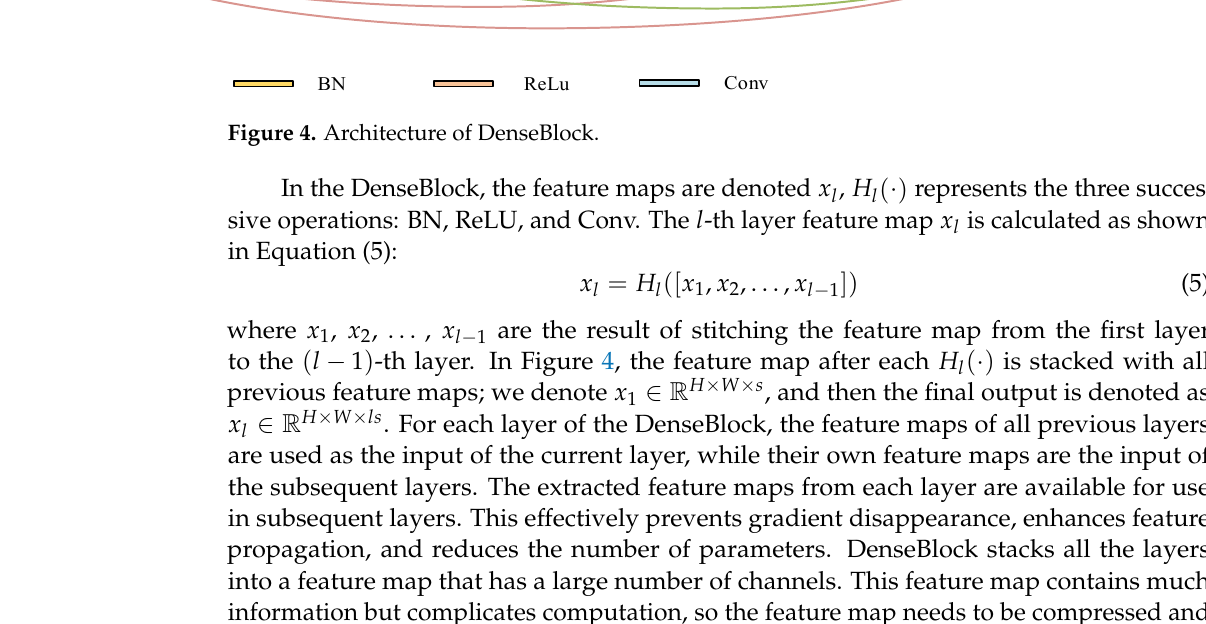
is stacked with